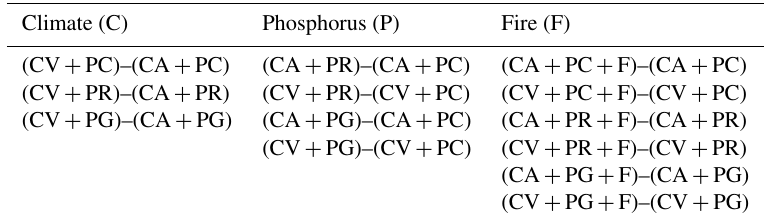
Table 2. Individual and combined effects for each simulation treatment for the Amazon–Cerrado transition zone. CA, monthly climato- logical average, 1961–1990. CV, monthly climate data, 1948–2008. Nutrient limitation on V max : PC, no P limitation ( V max =